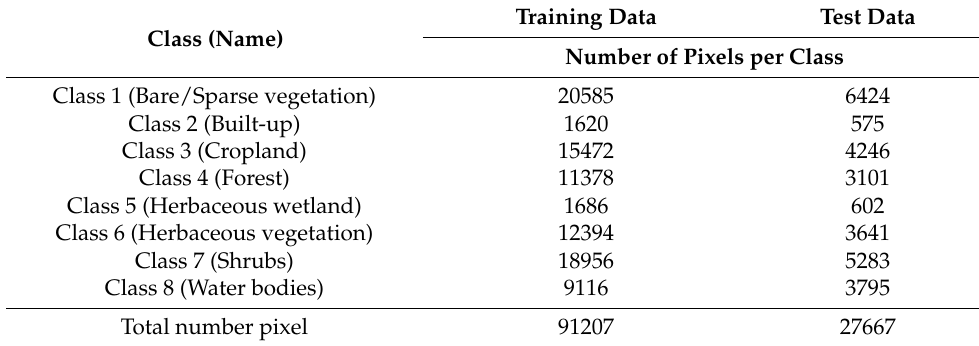
Table 3. Reference data per individual